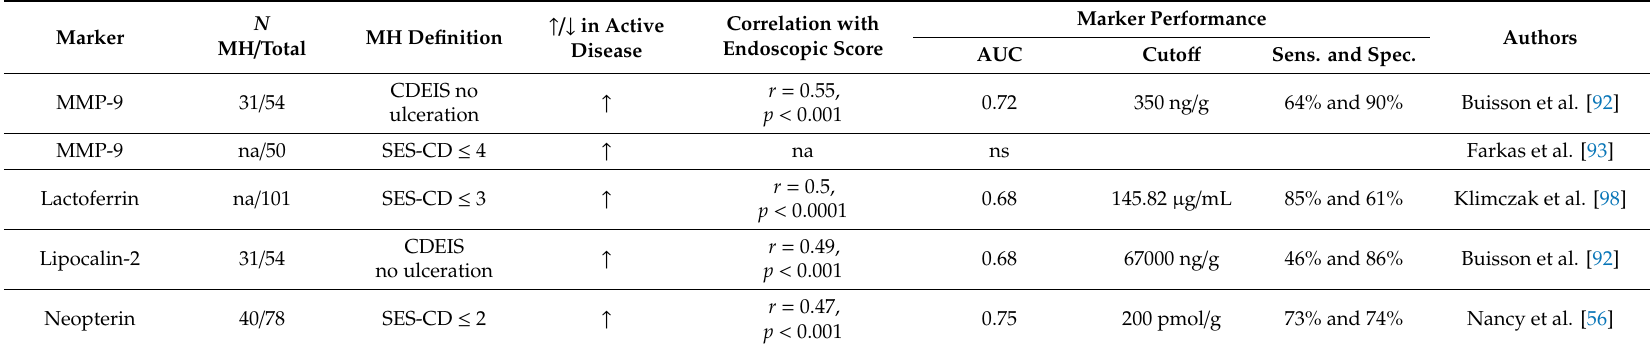
Table 5. Diagnostic performance of other fecal markers in MH detection for Crohn’s